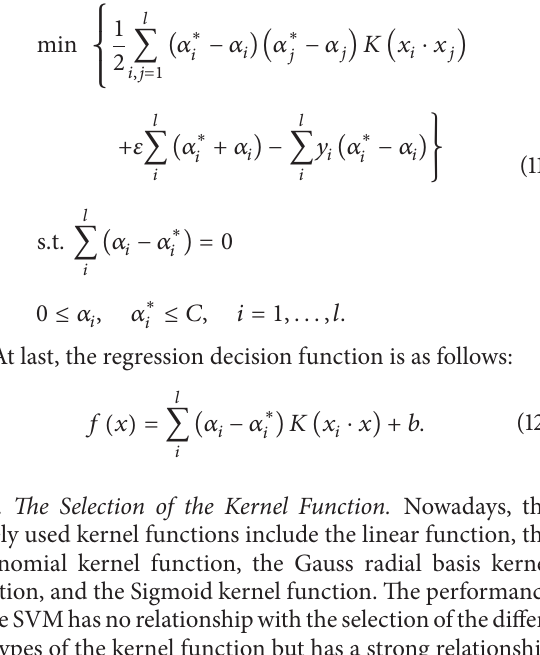
Table 2: The error analysis of B-spline surface fitting